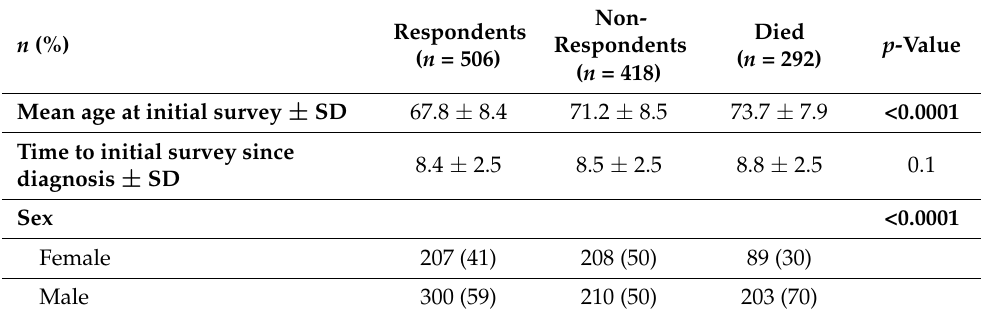
Table 1. Characteristics of sample according to response to follow-up